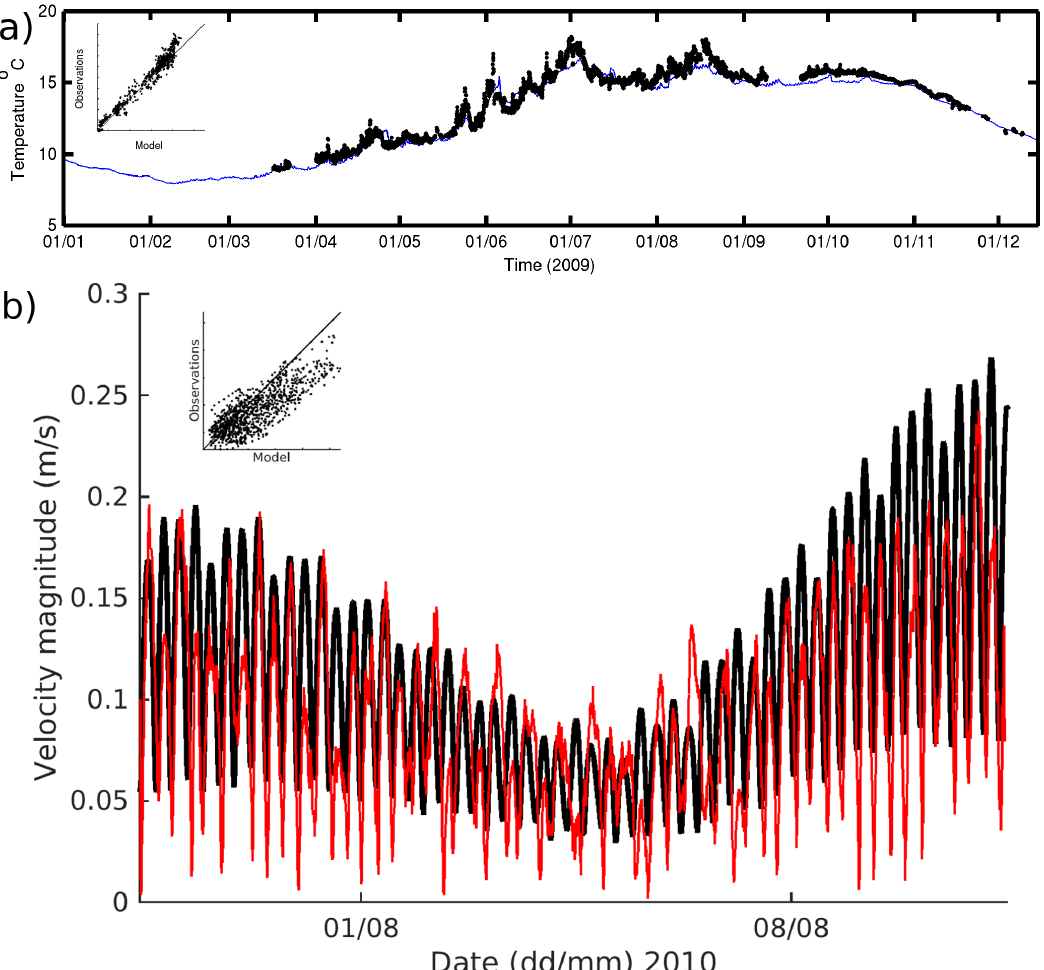
Figure 2. Time evolution of ( a ) Six hourly SST as simulated with GOTM (solid line) and observed from the L4 buoy (dots) and ( b ) velocity magnitude averaged between 1 and 2 m from the sea bed for the model and observations. The one to one plot with all data used in calculating the statistics is included in the left top corner. The axes have the same range as the main